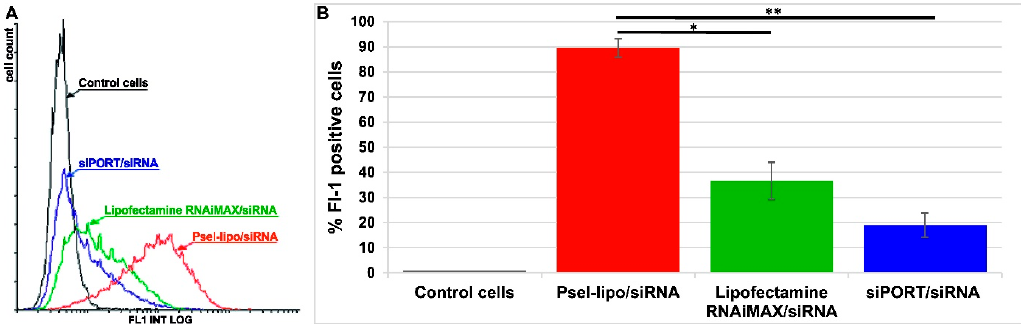
Figure 6. ( A ) Flow cytometry histogram overlay showing FITC-positive bEnd.3 cells after incubation with Psel-lipo/FITC-siRNA lipoplexes (charge ratio R +/ − = 4; 20 nM siRNA), Lipofectamine™ RNAiMAX/FITC-siRNA and siPORT™/FITC-siRNA. ( B ) Flow cytometry bar graph shows data as mean ± S.E.M. (representative experiment performed in triplicate) *p < 0.05, **p < 0.01.